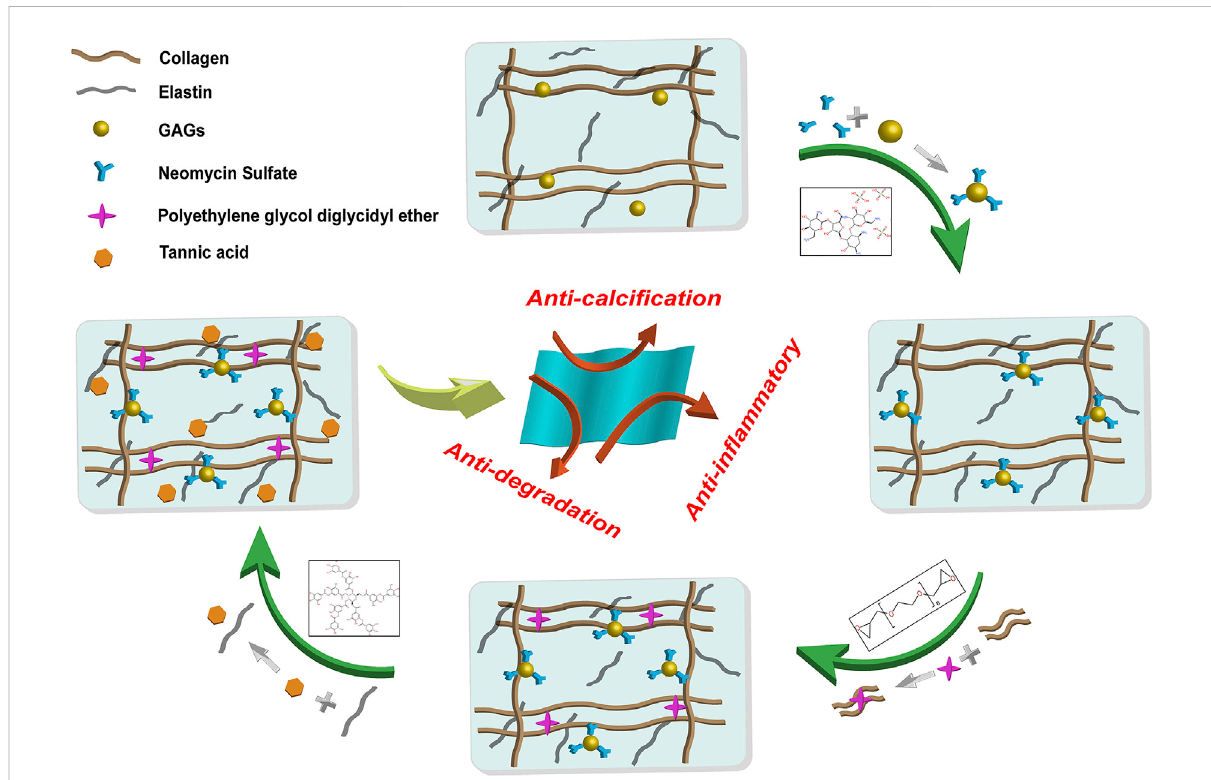
FIGURE 1 General procedure and reaction principle of the preparation of the hybrid crosslinked bovine pericardium. The method was followed by Neomycin to stabilize GAGs, PE to stabilize collagen fi bers, and Tannic acid to stabilize elastin. GAGs: Glycosaminoglycans. PE: Polyethylene glycol diglycidyl